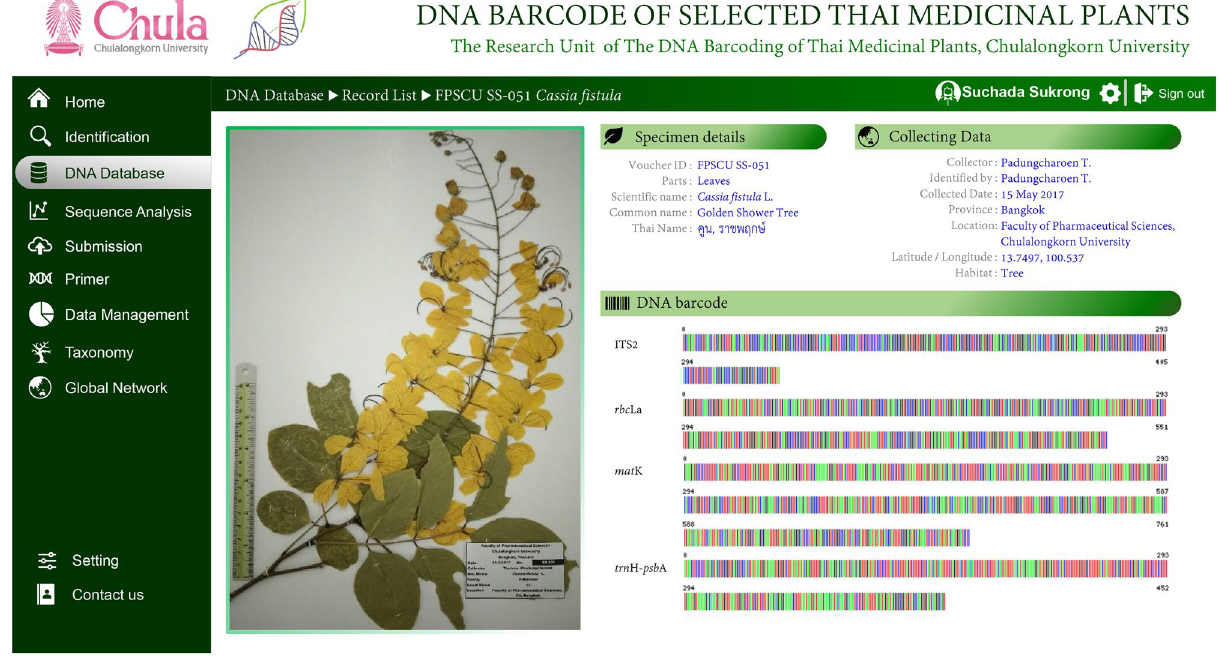
Figure 3. Overview of the proposed digital reference DNA barcode